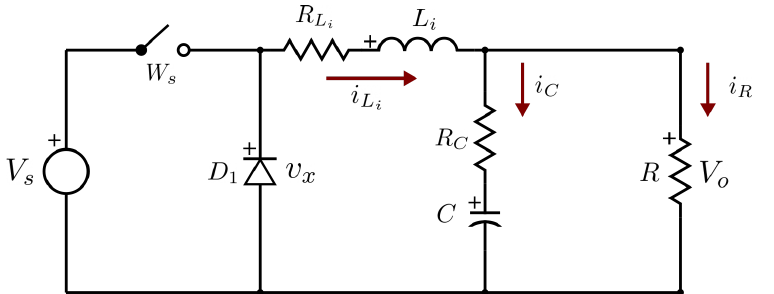
Figure 1. DC-DC buck converter topology. The ESR of the capacitor C and the inductor L i are